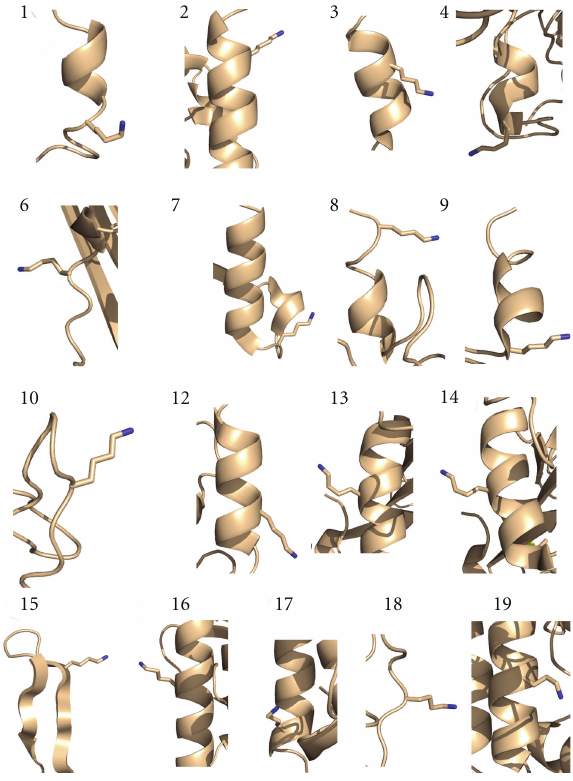
Figure 4: Structural context of methylation sites in RNAP subunits. Numbering is taken from Table 1. Fifteen of the sites are situated in α -helices whilst site 7 is in a hairpin turn and site 15 is situated in the β -sheet region of a β -hairpin. All structures are from S. shibatae RNAP structure (PDB 2WAQ) with the exception of 8, 9 and 10 which are from the S. solfataricus RNAP structure (PDB 2PMZ) as the two structures di ff er in this region of the E (cid:3)